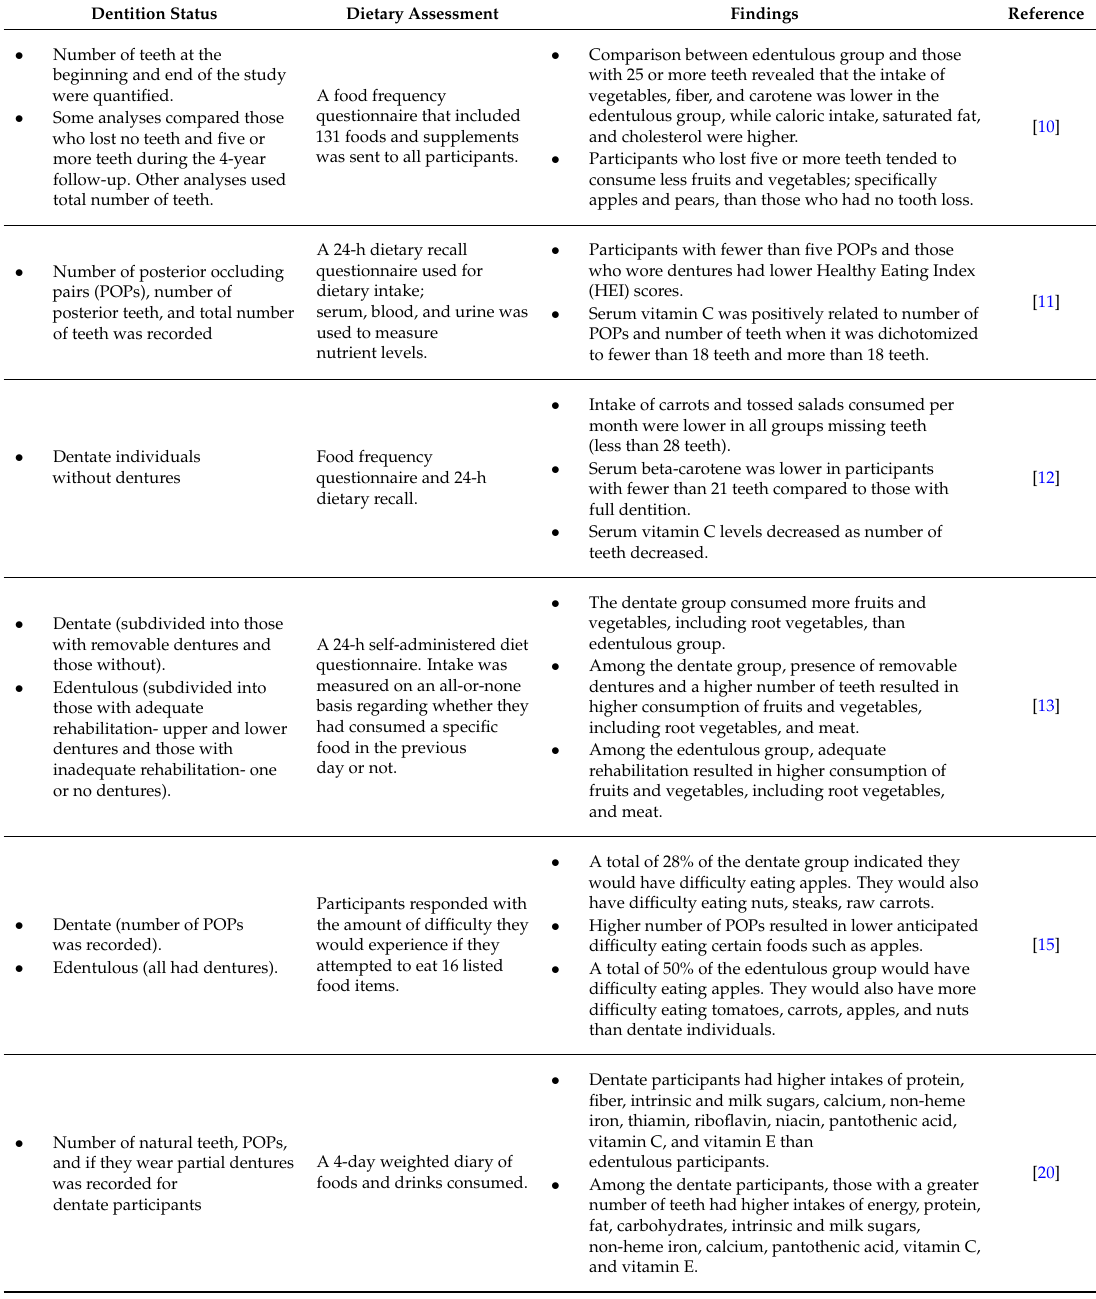
Table 1. Summary of findings regarding dentition and food